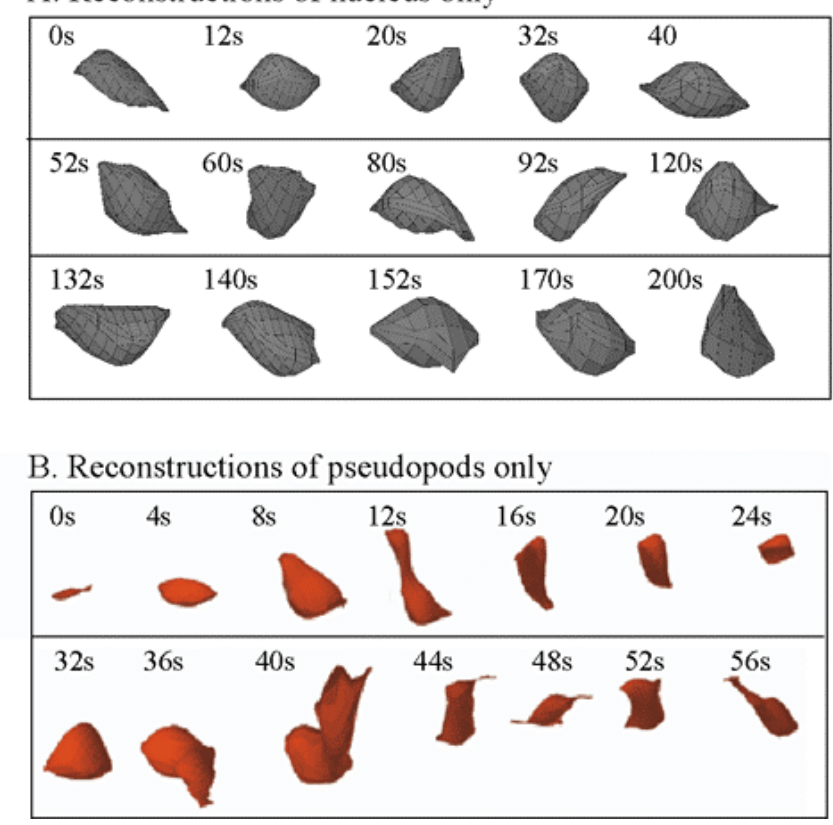
FIGURE 4. 3D-DIAS reconstruction of (A) the nucleus of a single cell over a 200-s time period and (B) the pseudopodial regions of a cell over a 56-s time period. The cell type is a D. discoideum amoeba.